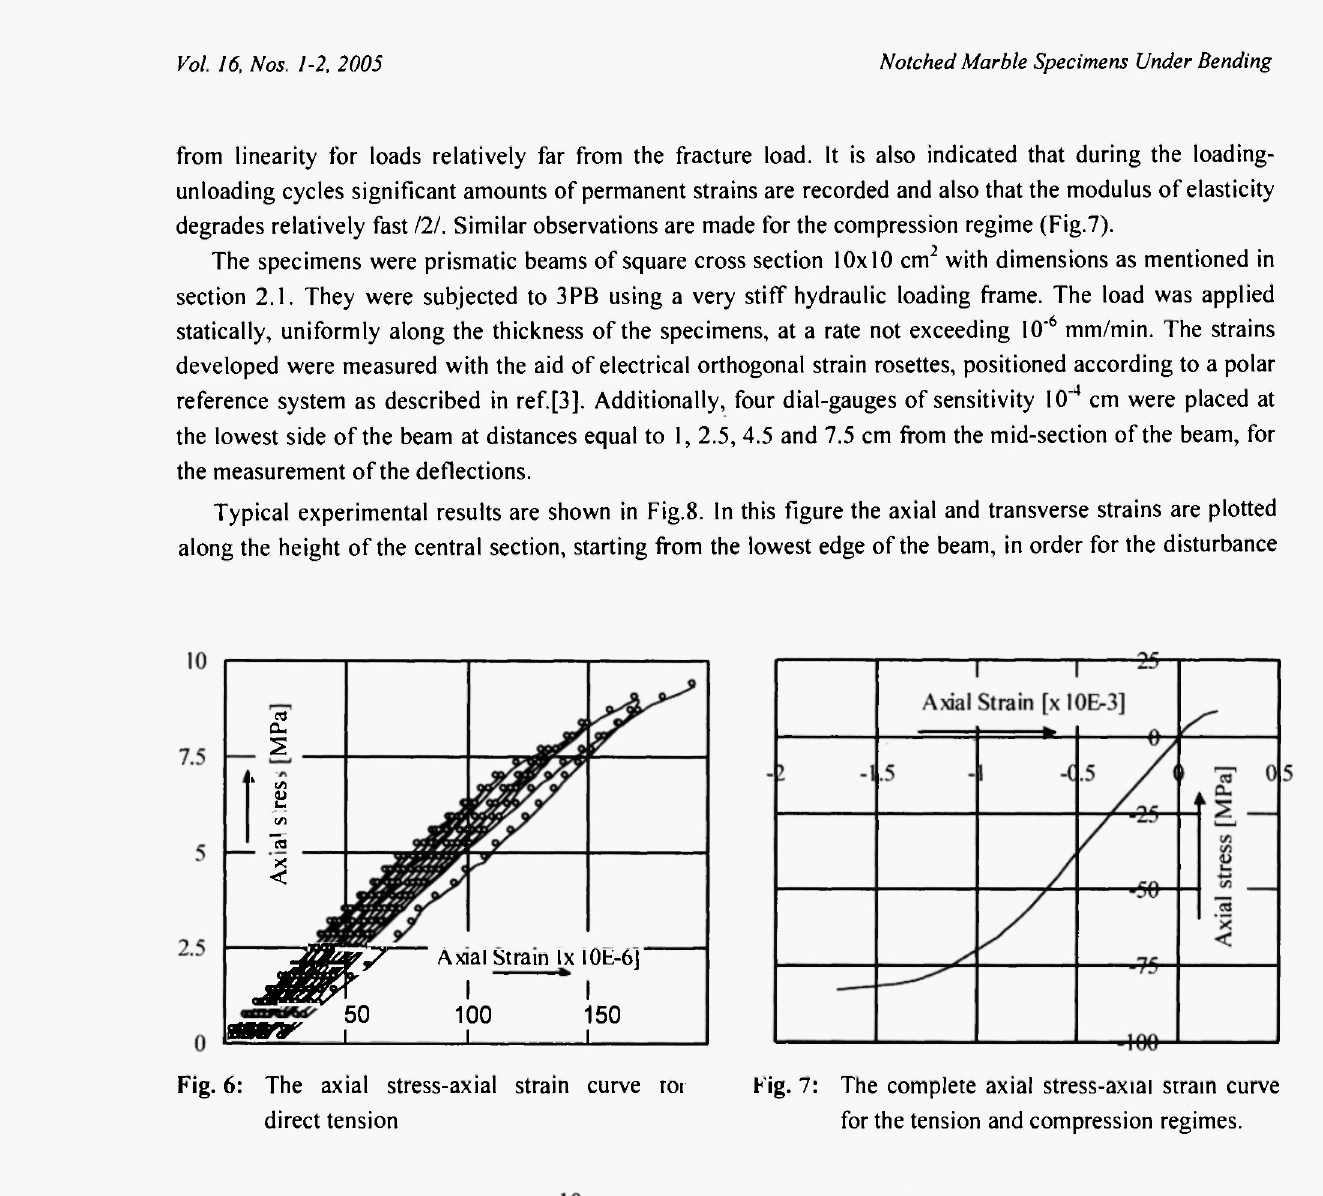
Kig. 7: The complete axial stress-axial strain curve for the tension and compression regimes.